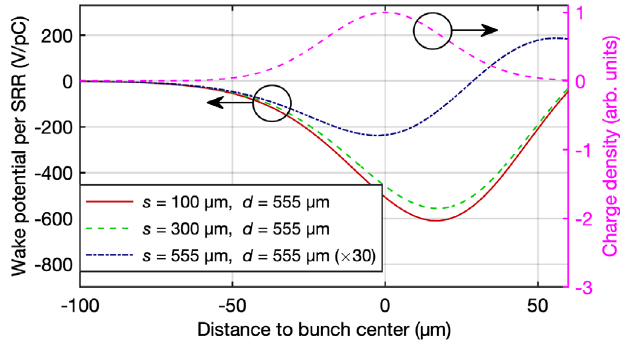
FIG. 7. Simulated on-axis wake potential per SRR normalized to the bunch charge as a function of distance to the bunch center (negative values refer to positions at the bunch front). For better visualization, the wake potential for a structure with s ¼ d ¼ FIG. 8. On-axis spectra for bunches with 100 MeVenergy, 5 pC 555 μ m is multiplied by a factor of 30. The longitudinal bunch charge, 1% relative energy spread and for different THz electric ¼ 20 μ m is shown as pink dashed curve. charge density with σ field z